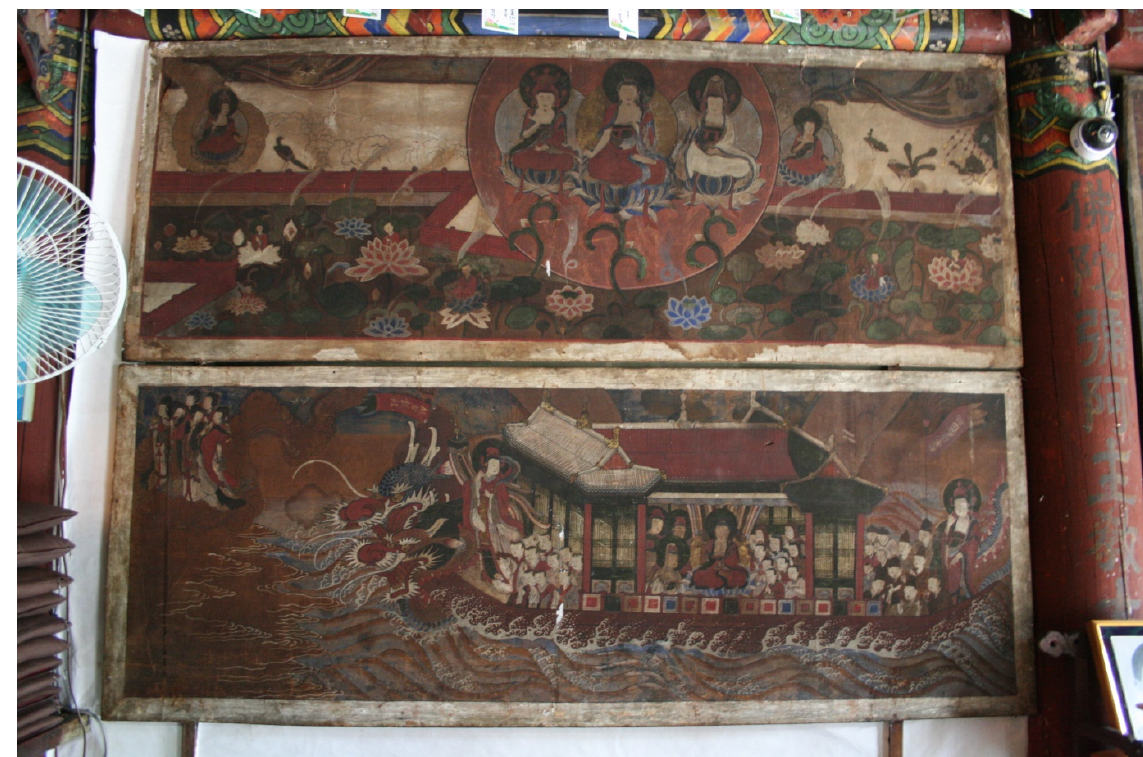
Figure 10. Amitābha’s Pure Land , circa 1915. Colors on silk. 68.5 × 203.0 cm each. Anyang’am, Seoul. Photograph by the author.